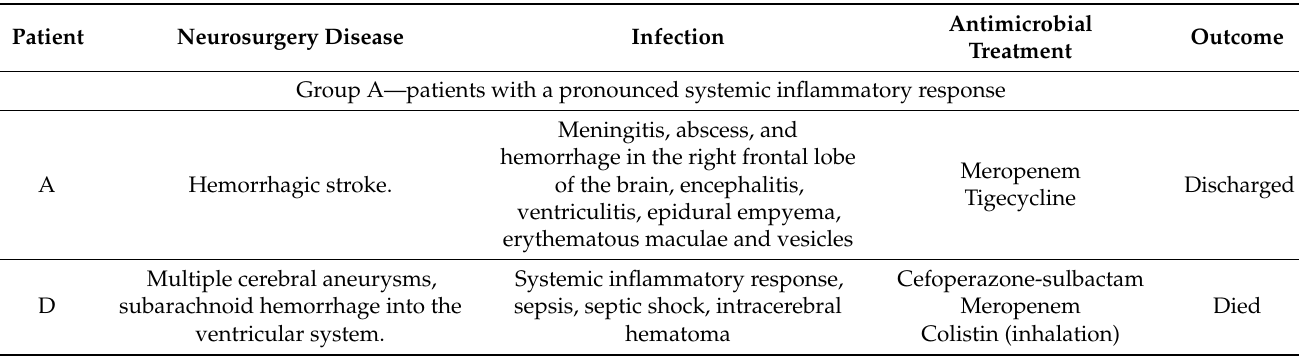
Table 1. Clinical data of the patients: underlying disease, infections, antimicrobial treatment, and outcomes. Patient Neurosurgery Disease Infection